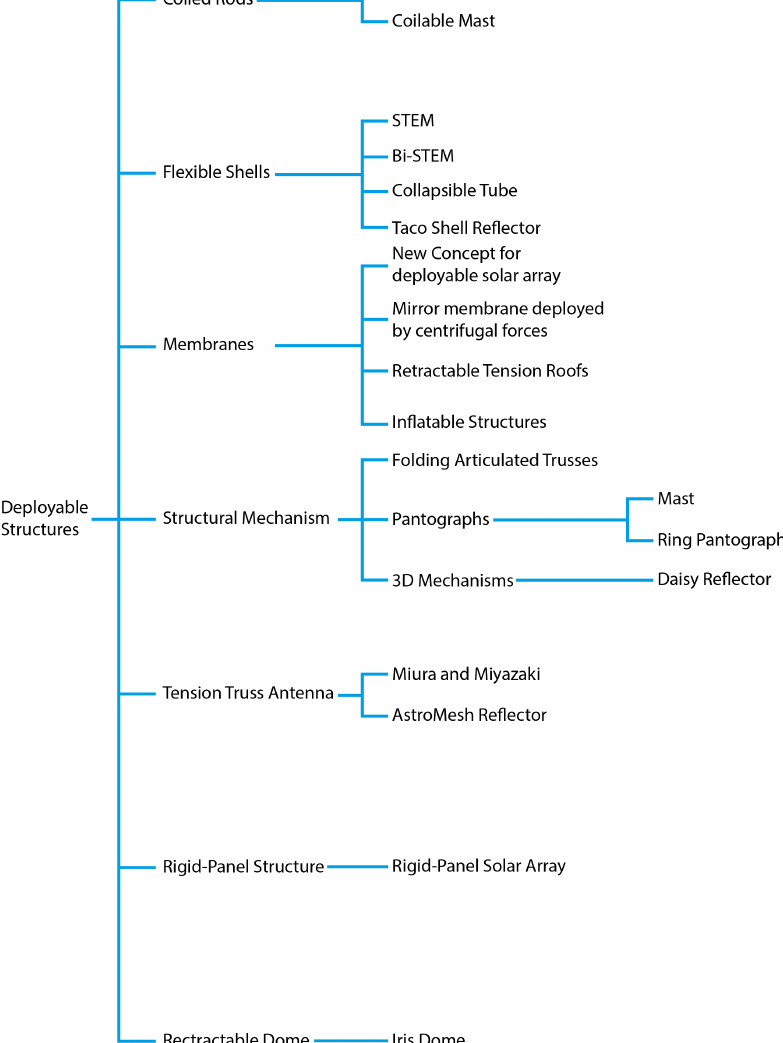
level of division is based on the application. Two classes are earth-based and spatial structures, depending on whether the self-weight plays an important role within the structure. Still, some of the structures from different classes have very similar kinematics and morphology, so the division is not so clean-cut [17]. Within the earth-based structures, there are pantographs, two-dimensional panels, cable and mem- brane structures, pneumatic structures, tensegrities and re- tractable roofs. It is important to notice that the subclasses here are structural forms for all the members besides the retractable roofs. They are defined by their application. Con- sidering the space-based structures, there is no lower level of classification. In this classification, pantographs are clas- sified under the earth-based deployable